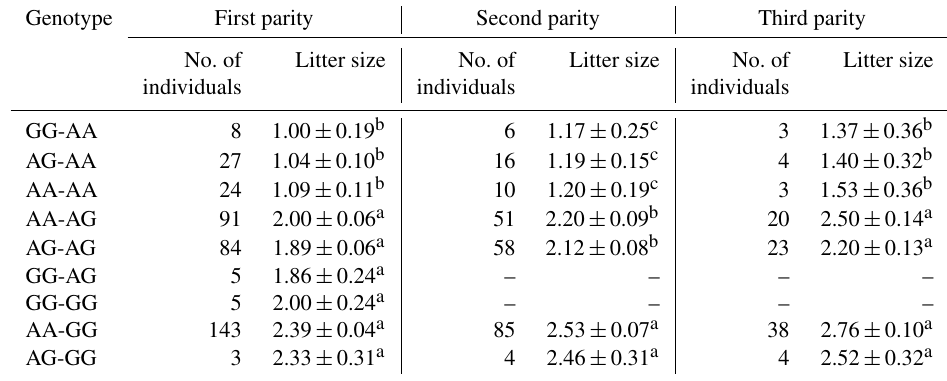
Table 6. Analysis of combined genotypes of BMPR1B (g.29380965A > G) and FecB and litter size in small-tail Han sheep. Genotype First